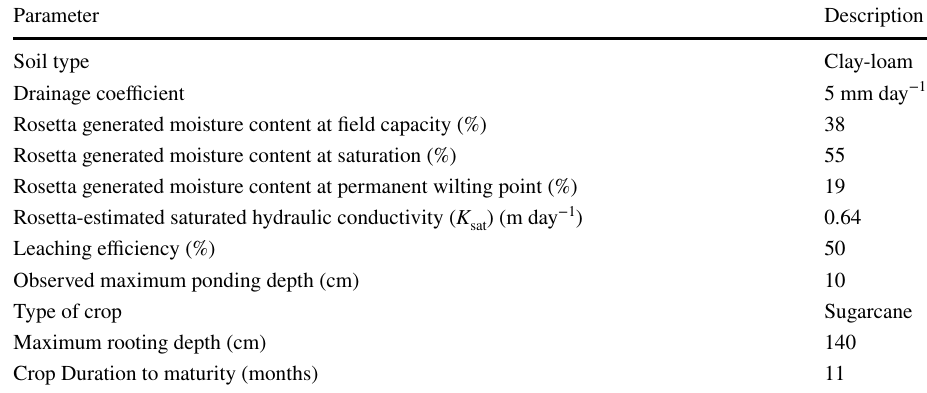
Fig. 2 A comparison of the Rosetta estimated and the meas- ured K sat values for different land units and soil